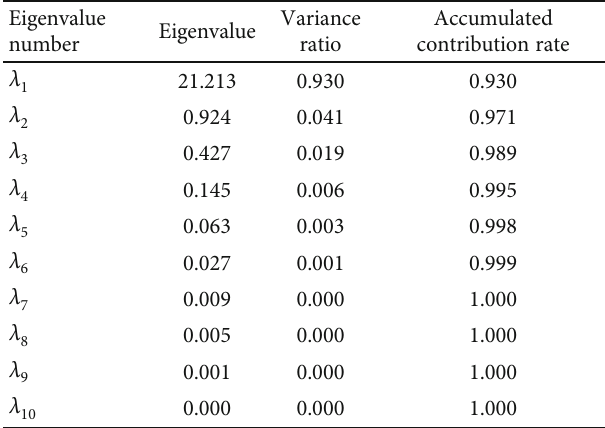
Table 4: Cumulative variance contribution rate table of roll vibration signals for fl exible material R2R